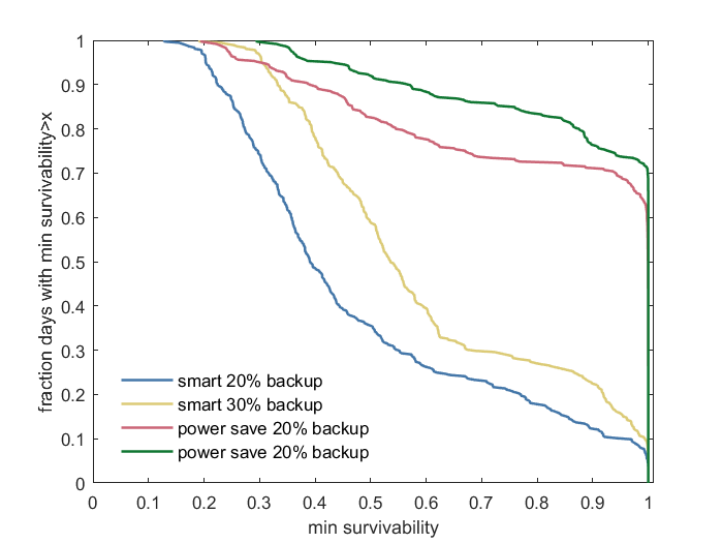
Figure 8. Complementary experimental cumulative distribution of the minimum survivability per day.